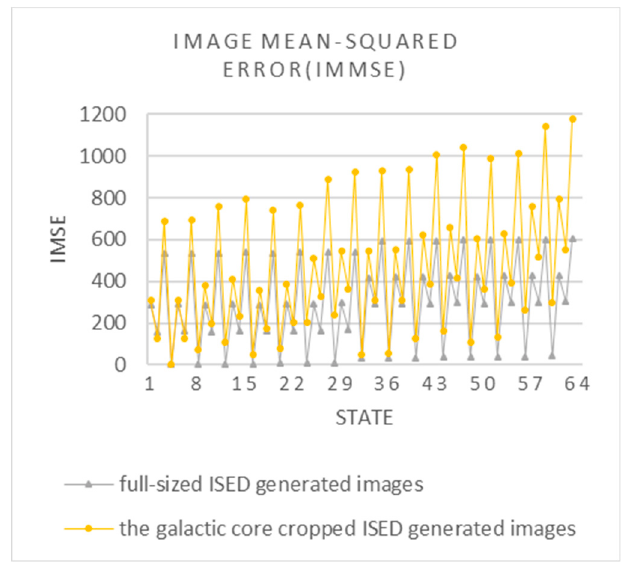
Figure 12. IMSE values of 63 ISED-generated images. The cropped images of M87 can be seen in Figure 9.